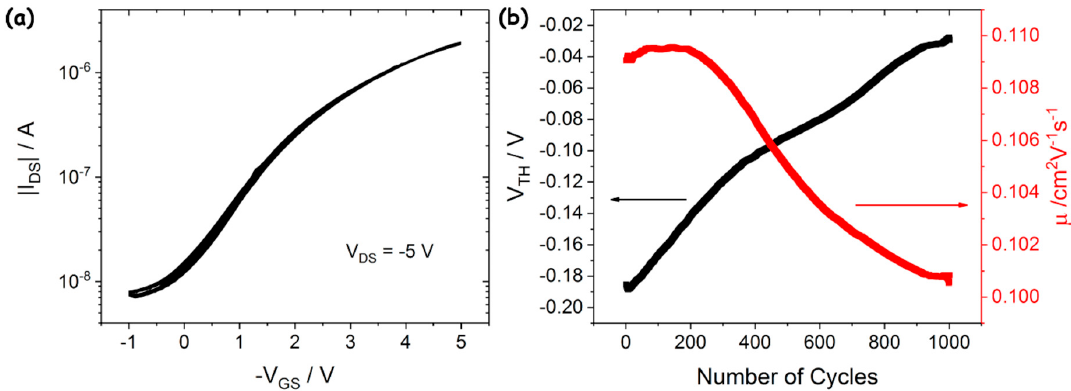
Figure 3. ( a ) 1000 double-sweep transfer characteristic curves acquired in saturation regime at VDS = − 5 V; ( b ) threshold voltage (black, left axis) and mobility (red, right axis) absolute variations extrapolated by the square root of curves in ( a ).